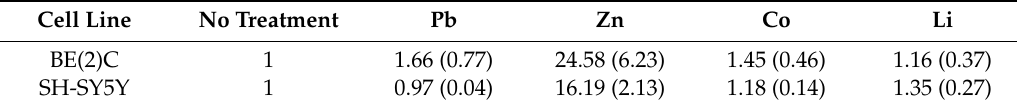
Table 3. Relative MT2 mRNA levels after metal treatment. All results are normalized to non-metal treated control cells and the housekeeping gene HSP90ABI . Results are the average of 6 and 5 biological replicates, for BE(2)C and SH-SY5Y cells, respectively. Each biological replicate is the average of 3 technical replicates. Standard errors are presented in parentheses.